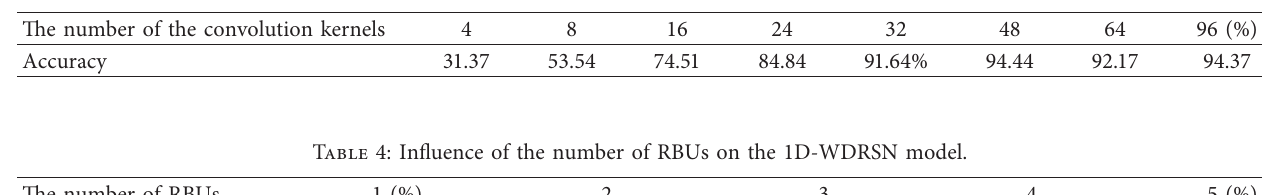
Table 3: Influence of the number of convolution kernels in the wide convolution layer on the 1D-WDRSN model.